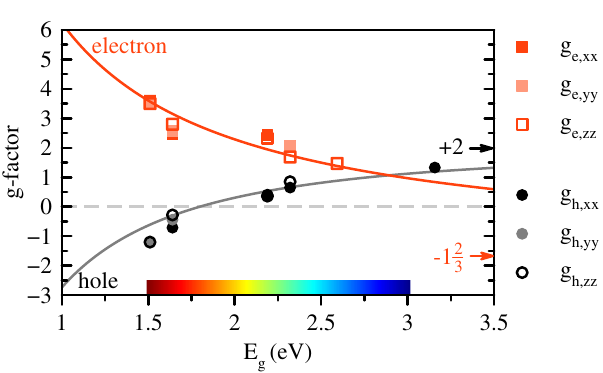
Fig. 5 Electron and hole g -factors versus band gap energy in lead halide perovskite crystals. Experimental data are given by the symbols. Solid lines are fi ts with Eqs. (5) and (6) using the parameters Δ = 1.5 eV, ℏ p / m = 6.8 eV Å , and Δ g = − 1. The limiting values of the electron ( − 5/3) 0 e and hole ( + 2) g -factors for E g → ∞ are given by the